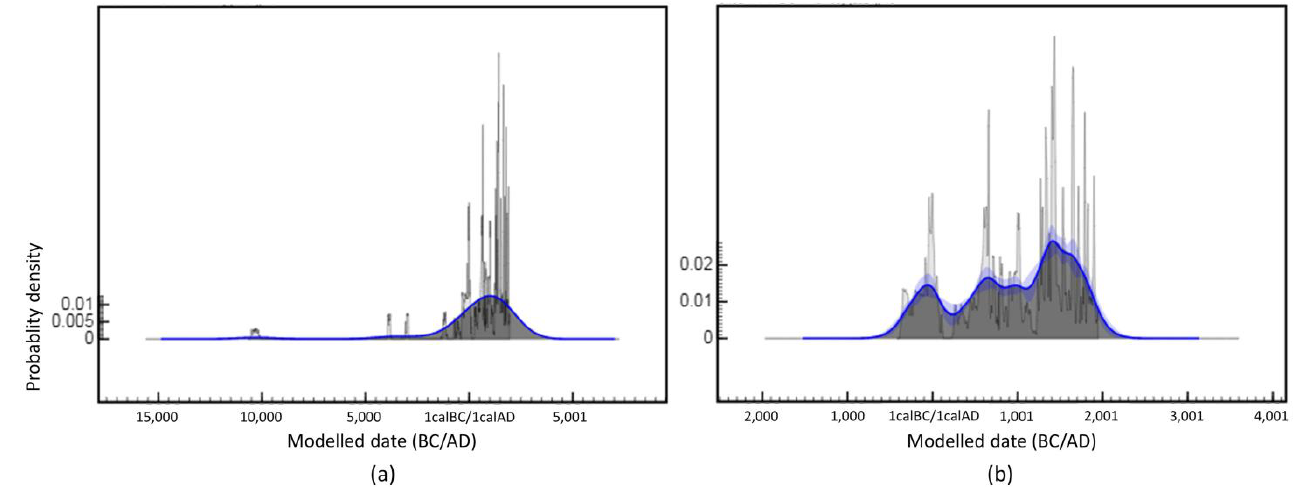
Figure 7. Calendar age distributions of forty-one ( a ) and thirty-six ( b ) charcoal samples estimated by the KDE method.